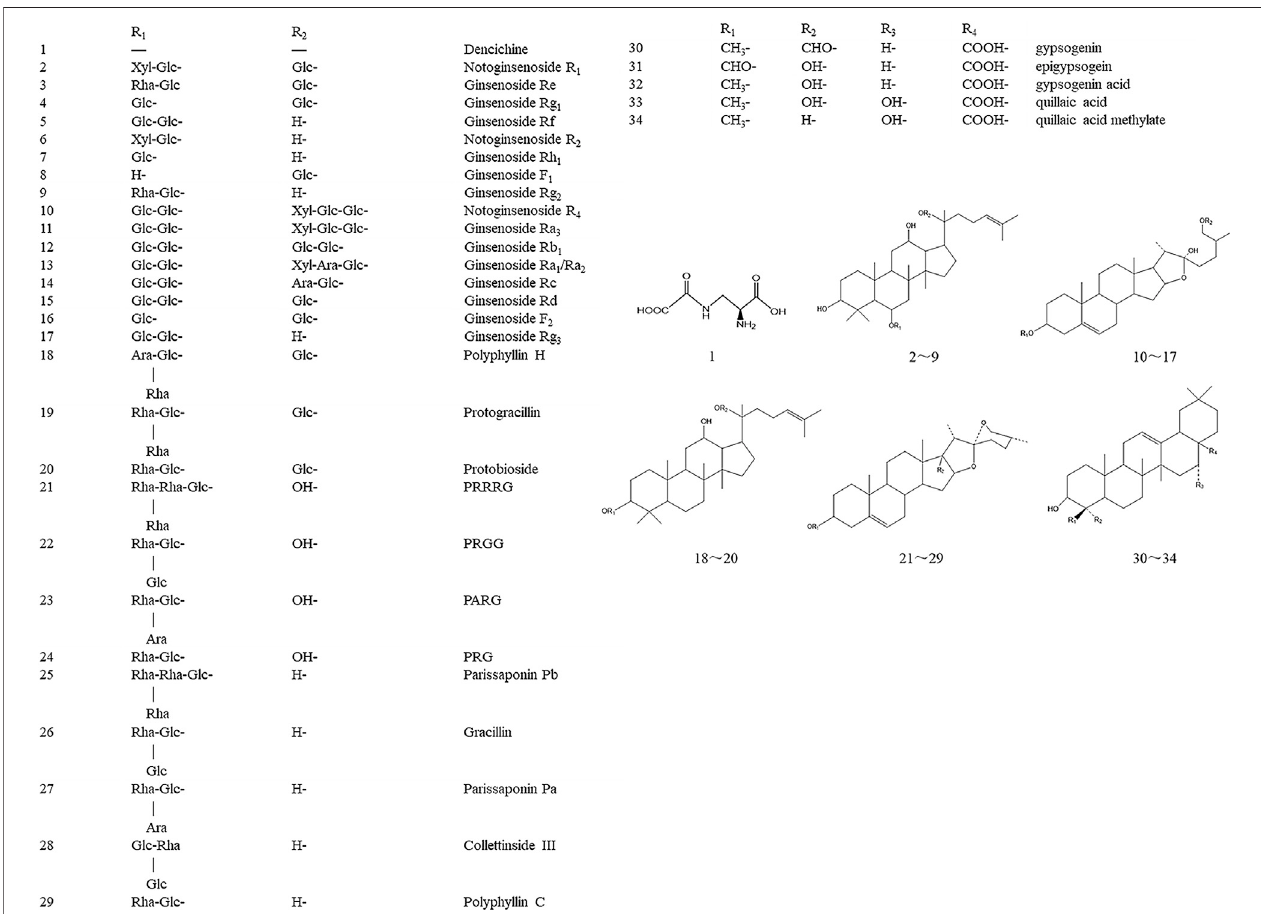
FIGURE 3 | Chemical structures and names of the 34 compounds isolated and identi fi ed from Yunnan Baiyao. Glc, b-D-glucose; Rha, a-L-rhamnose; Xyl, b-D- xylose; Ara, a-L-arabinose. PRRRG: pennogenin-3-O- α -L-rhamnopyranosyl(1 → 4)- α -L-rhamnopyranosyl(1 → 4)-[ α -L-rhamnopyranosyl (1 → 2)]- β -D-glucopyranoside; PRGG: pennogenin-3-O- α -L-rhamnopyranosyl(1 → 2)-[ β -D-glucopyranosyl(1 → 3)]- β -D-glucopyranoside; PARG: pennogenin-3-O- α -L-rhamnopyranosyl(1 → 2)-[ α -L- arabinopyranosyl(1 → 4)]- β -D-glucopyranoside; PRG: pennogenin-3-O- α -L-rhamnopyranosyl(1 → 2)- β -D-glucopyranoside.